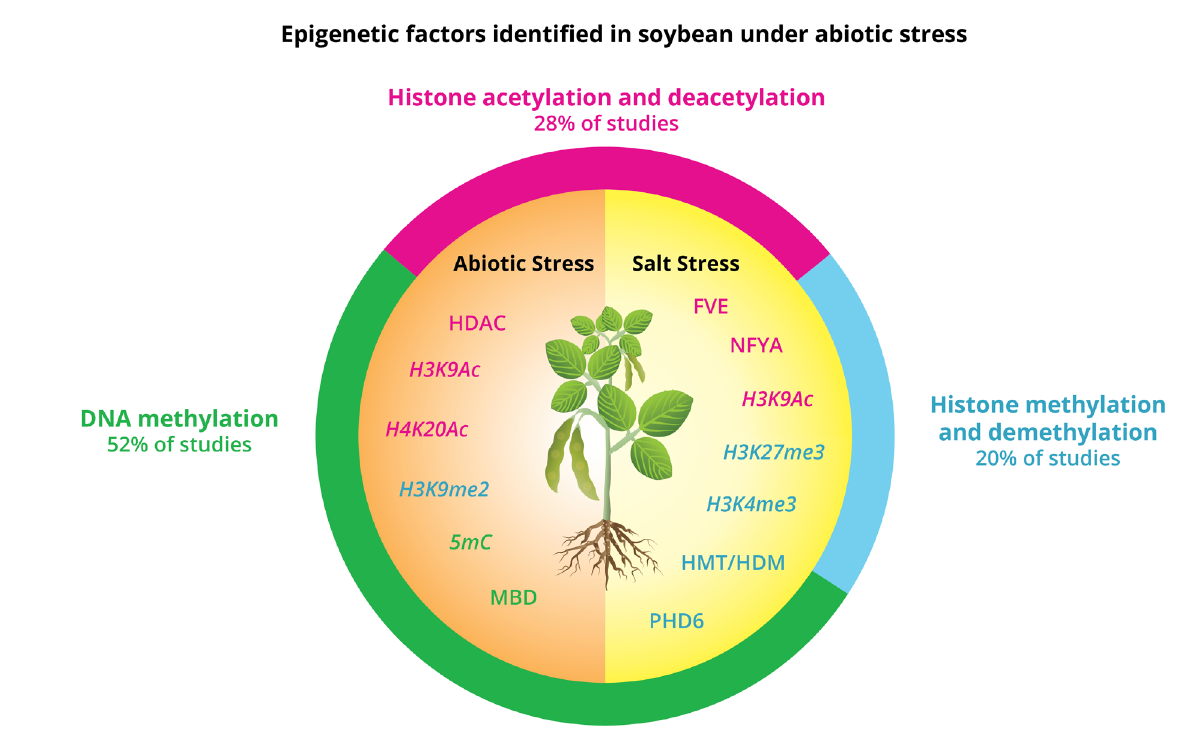
Figure 5 – Summary of epigenetic factor identified in soybean under abiotic stress. Epi genetic factors and marks are described in pink for histone acetylation and deacetylation, in blue for histone methylation and demethylation and green for DNA methylation. They are also grouped by salt or other abiotic stresses. The percentages of studies reviewed in each type of modification are